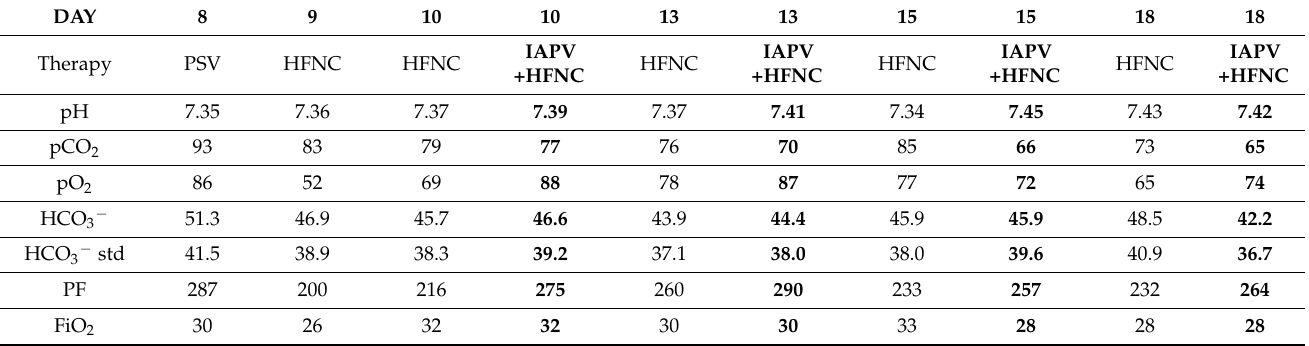
Table 1. Blood gas among days with different ventilation strategies. PSV: pressure support ventilation, HFNC: high flow nasal cannula, IAPV: intermittent abdominal pressure